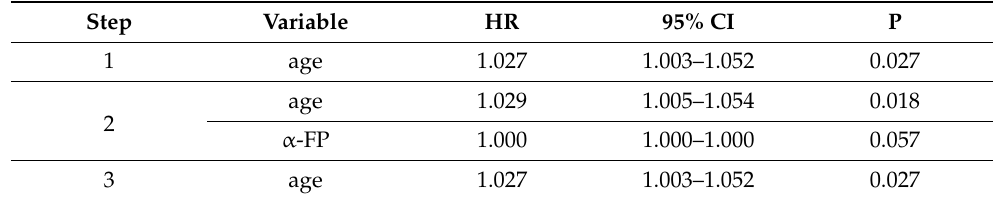
Table 3. Factors predictive of reduced survival on multivariate Cox Regression stepwise